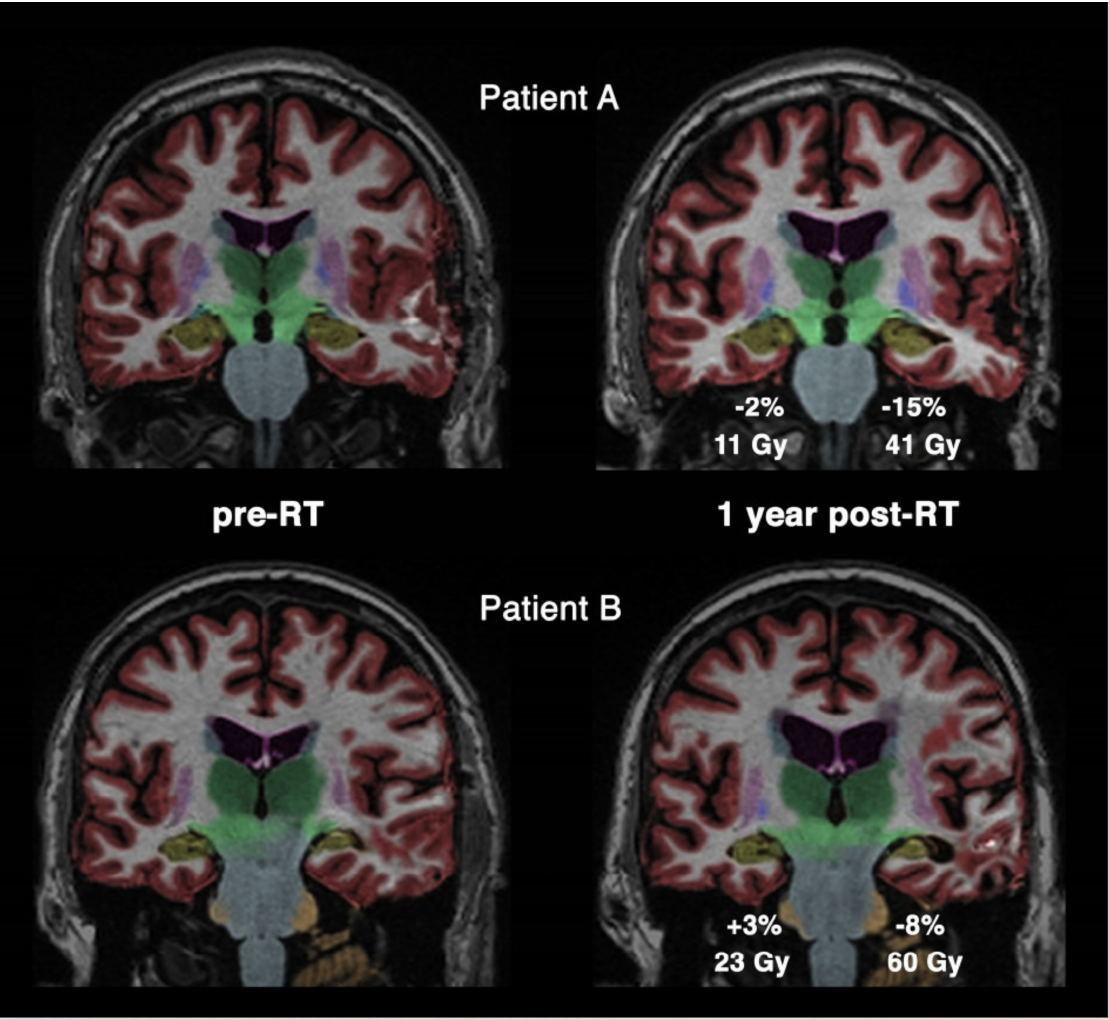
Figure 1. Hippocampal volume loss segmented in yellow for two cases ( A , B ). Comparison between measurements before radiotherapy (pre-RT) and one year after radiotherapy (post-RT) shows the different level of volume decrease for high- and low-dose irradiation. Reprinted from Seibert et al. [42] with permission from